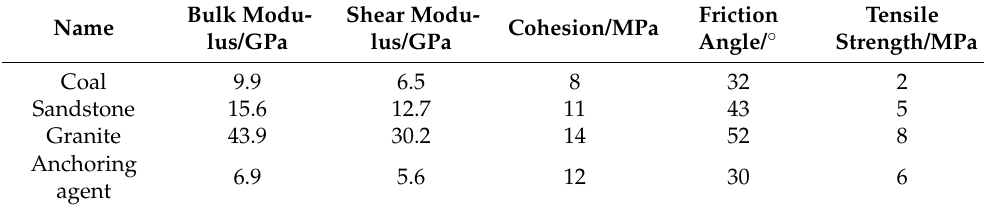
Table 1. Mechanical parameters of surrounding rock mass and anchoring agent.